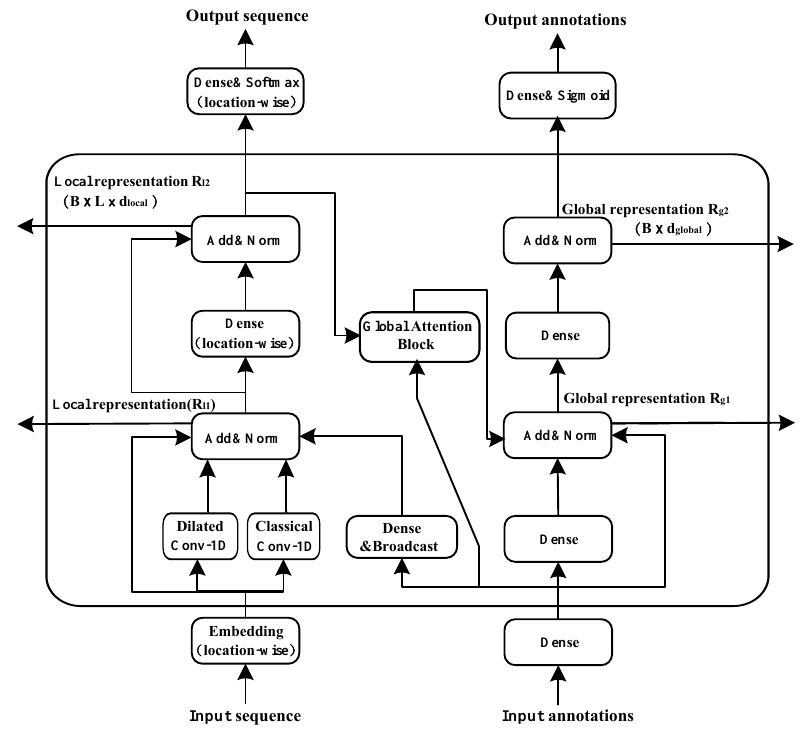
Figure 1. Structure of attention module in TLCrys pre-training